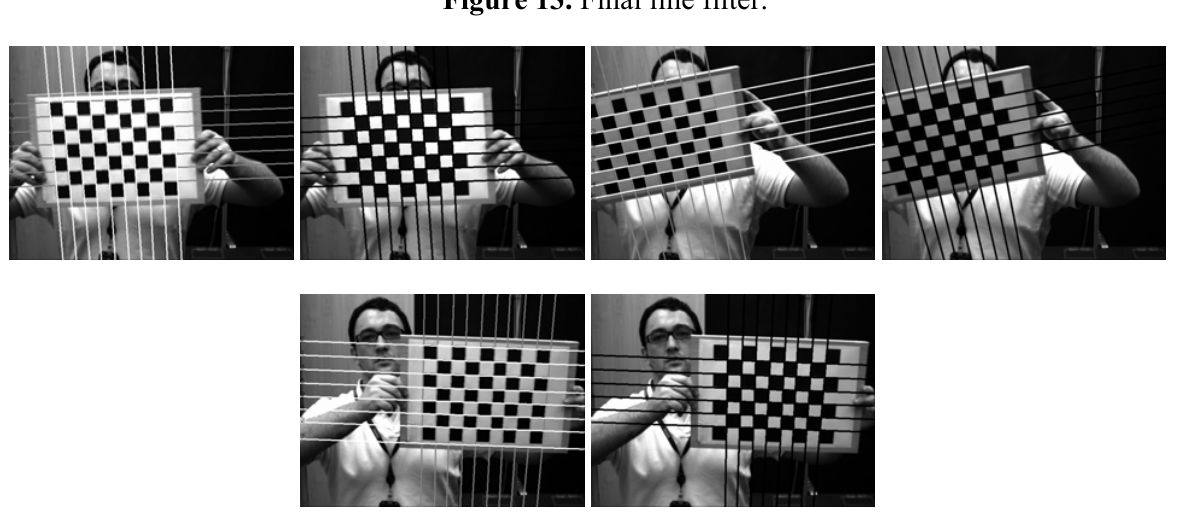
Figure 13. Final line filter.